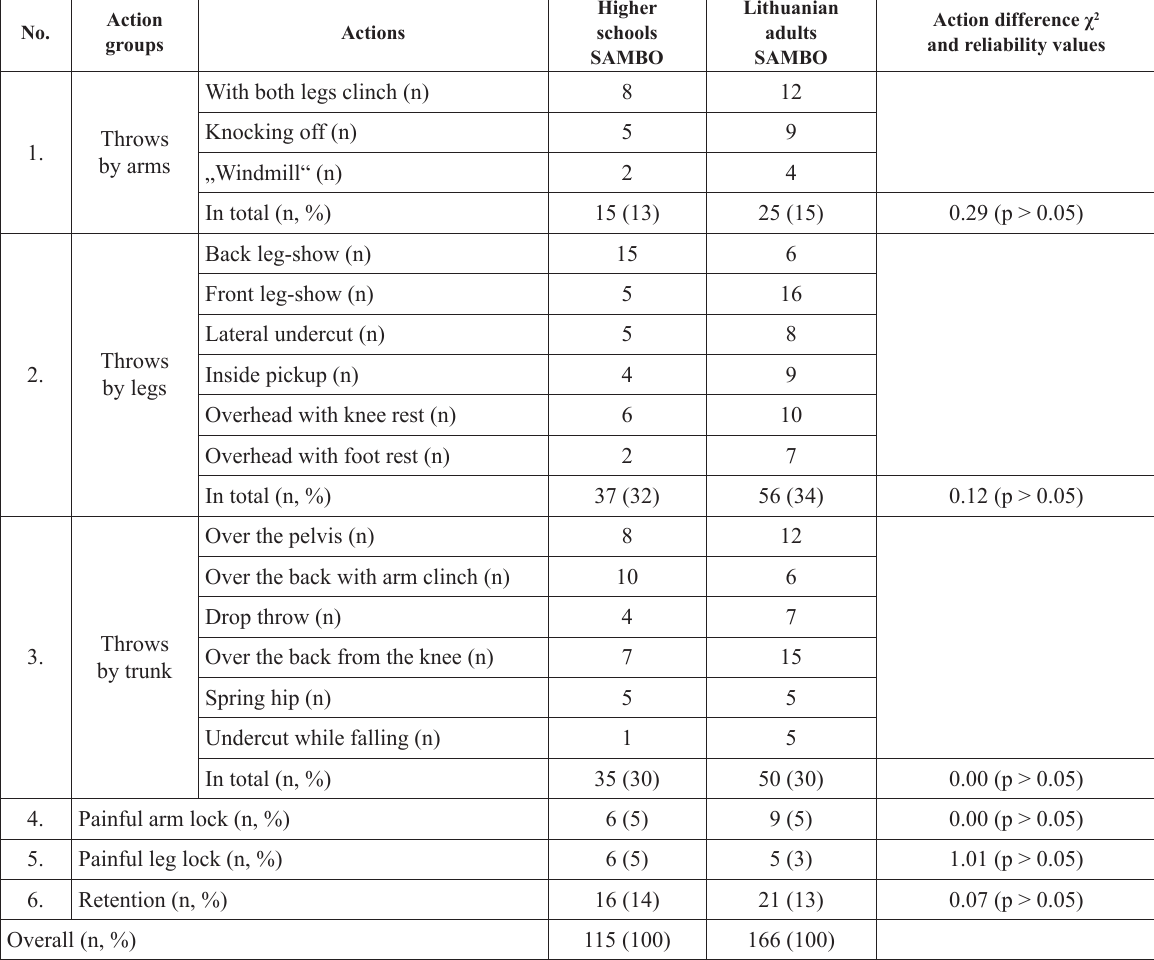
Table 1. Distribution of actions performed and evaluated by judges at Lithuanian higher schools and adults Sport SAMBO contests; reliability of the value differences